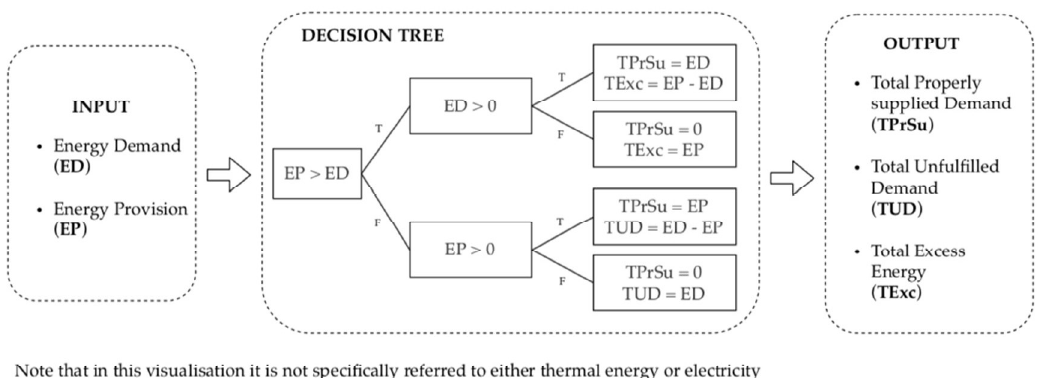
Figure 4. Overview of the applied spatiotemporal model (adapted after Camargo et al., 2015).